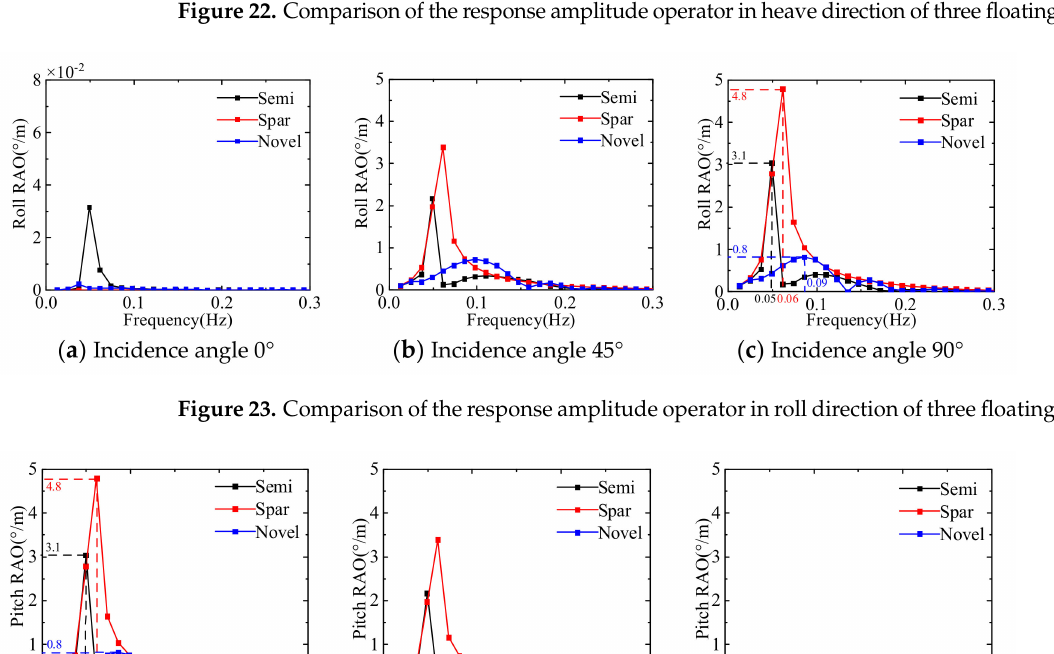
Figure 22. Comparison of the response amplitude operator in heave direction of three floating platforms.